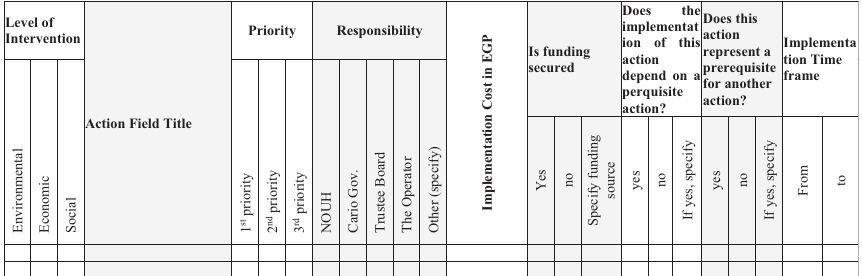
Figure 7. A guiding tool for prioritization of action fi elds of interventions, the